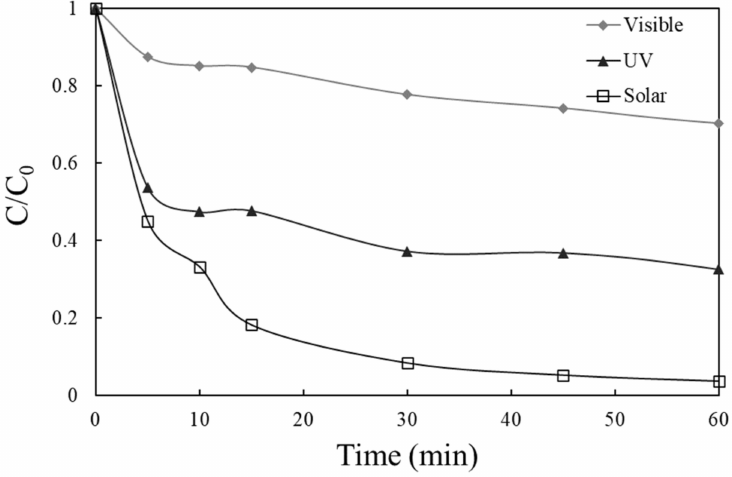
Figure 7. Effect of the type of irradiation on 0.5 mg/L VLS degradation with 1000 mg/L 0.25 MoS 2 /BiOCl in UPW.